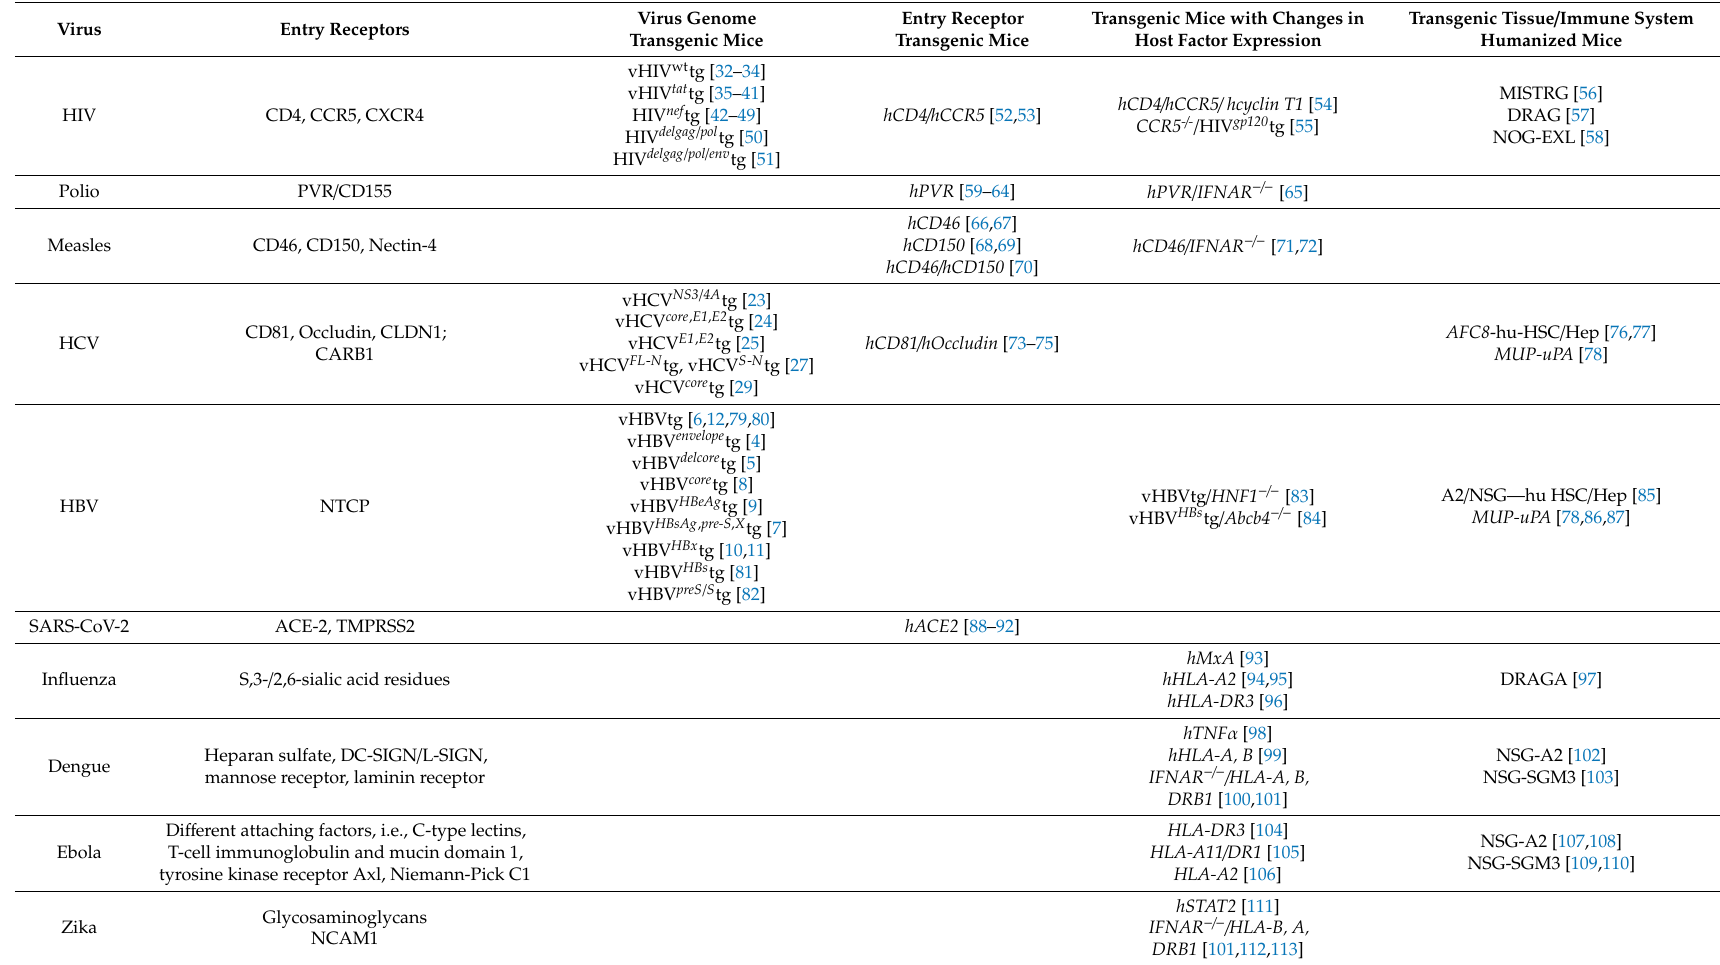
Table 1. Overview of transgenic mouse models used to study infections by a selection of human pathogenic viruses. This table can only give an overview and makes no claim to